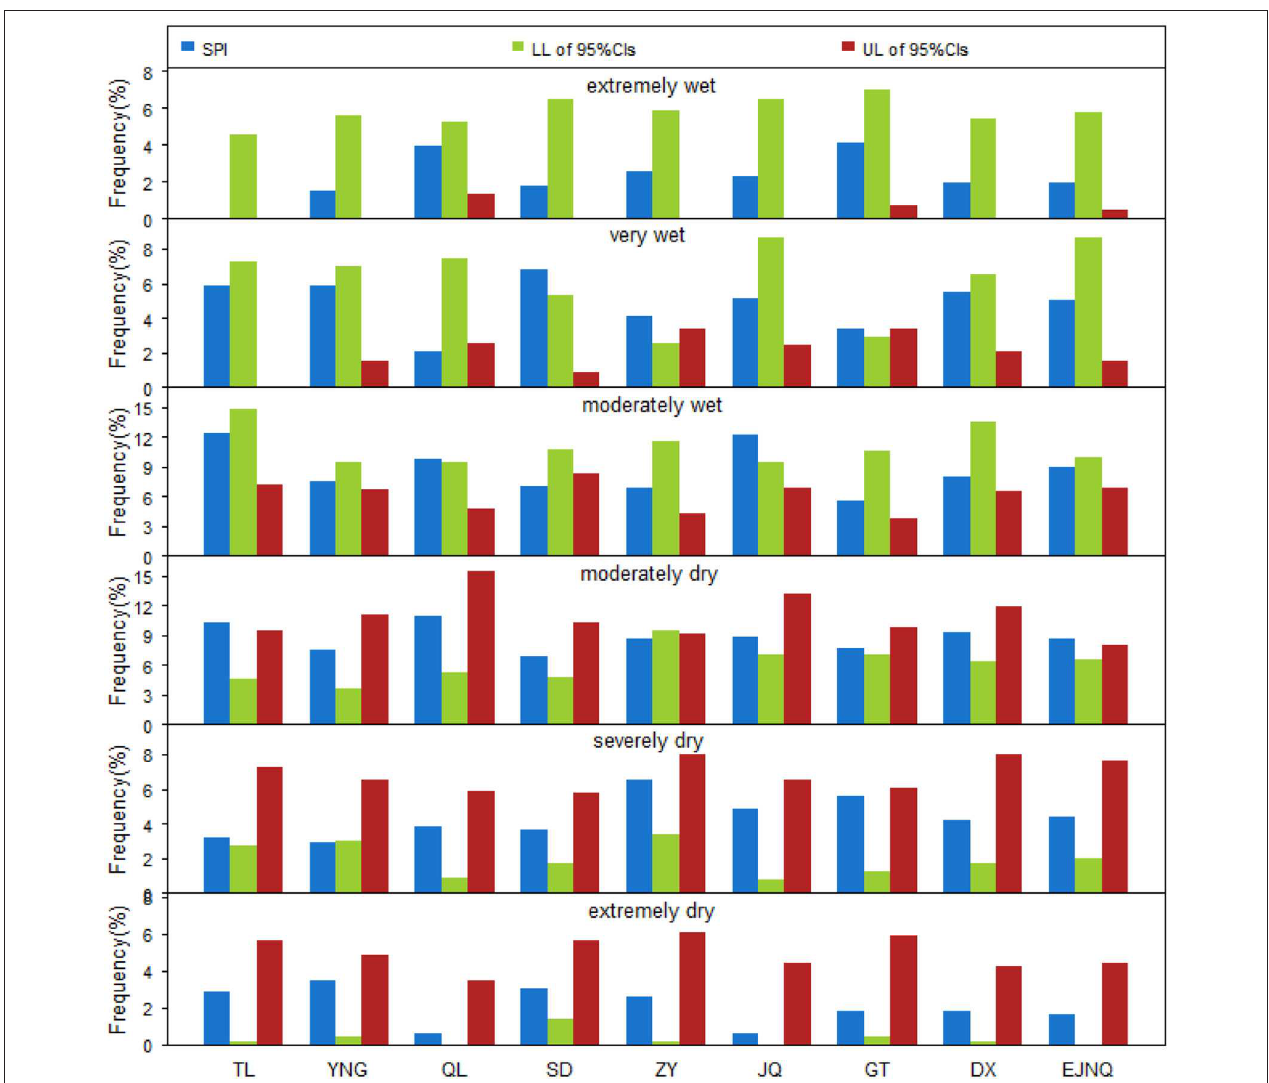
FIGURE 10 | Drought classification frequency based on SPI values considering parameter estimation errors (LL and UL are the lower and upper limits of 95% CIs, respectively; the abbreviated names of stations are the same as in Figure 3